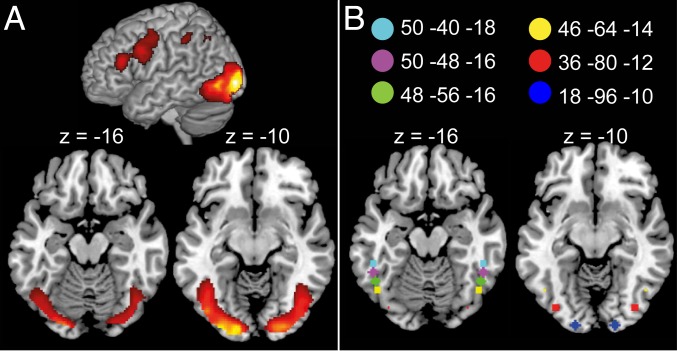
(A) Univariate activation during reading of trained words, P < 0.001 uncorrected, P < 0.05 familywise error cluster extent corrected. (B) Location of 4-mm-radius spherical vOT ROIs taken from ref. 9.